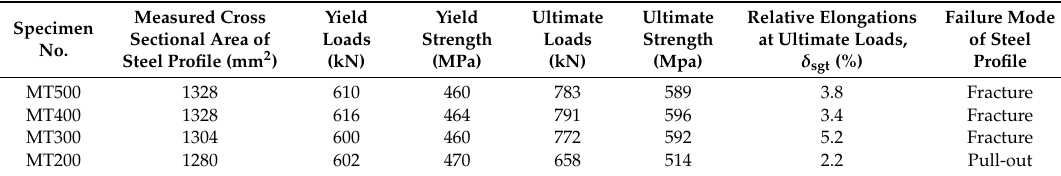
Table 5. Primary results for specimens in the first test